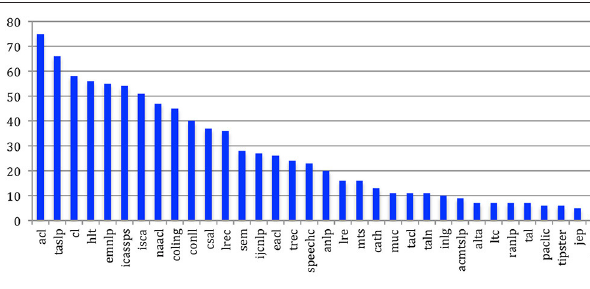
FIGURE 56 | General h-index of the 34